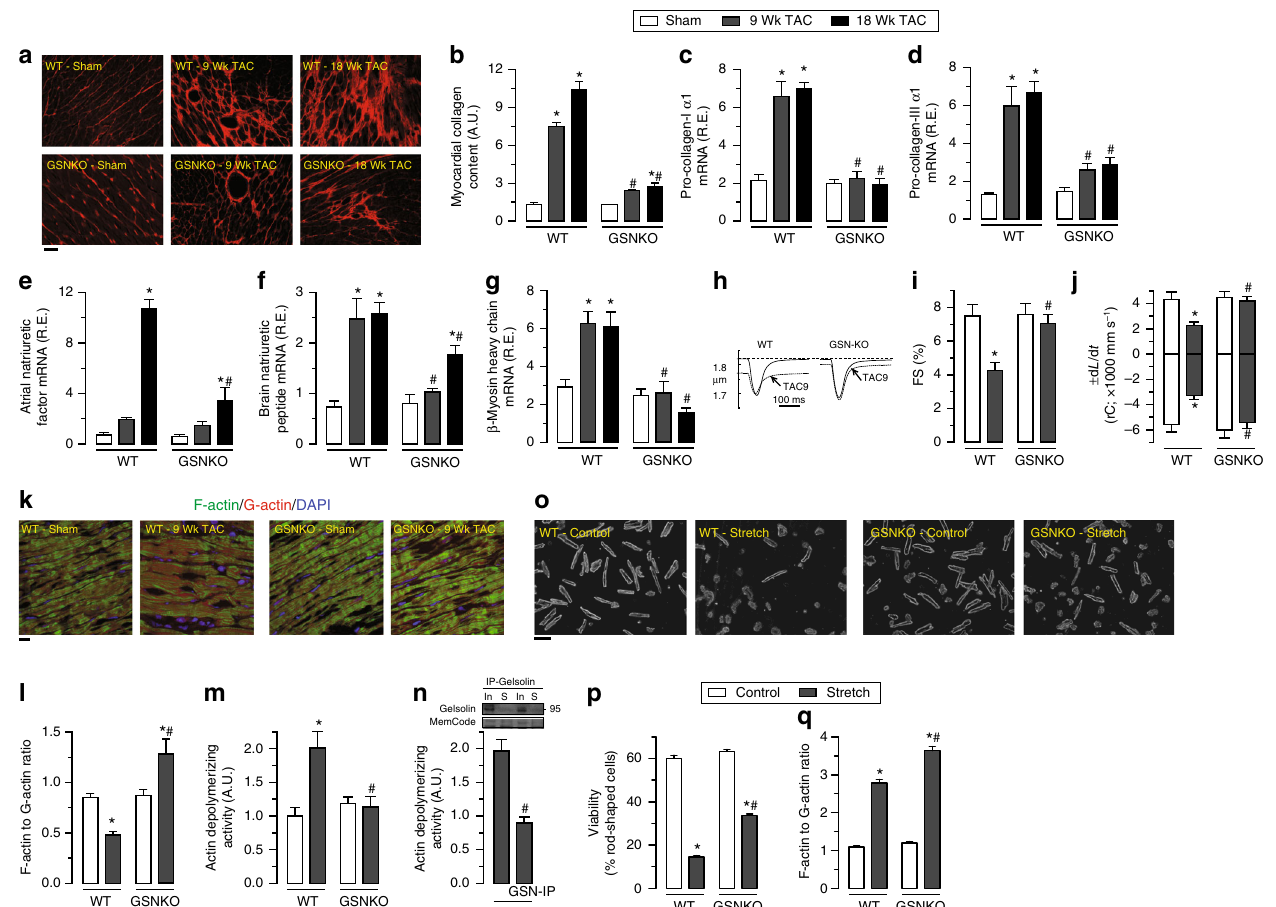
Fig. 2 Loss of gelsolin attenuates pressure overload-induced cardiac remodeling and adverse cytoskeletal remodeling. a , b Histological analyses by PSR ( a ) staining showing increased myocardial fi brosis ( b ) in WT mice which were attenuated in GSNKO mice. c , d Taqman real-time PCR analyses showing increased mRNA expression of pro-collagen-I α 1 ( c ) and pro-collagen-III α 1 ( d ) in WT mice in response to pressure overload-induced biomechanical stress. Loss of gelsolin resulted in attenuation of pressure overload-induced mRNA expression of these extracellular matrix proteins. e – g Taqman real-time PCR analyses showing attenuation of pressure overload-induced increase in mRNA expression of cardiac disease markers including ANF ( e ), BNP ( f ), and β - MHC ( g ) in GSNKO mice compared with the WT mice at 9 and 18 weeks postsurgery. h – j Single cardiomyocyte contractility measurements ( h ) showing attenuation of decreased myo fi lament FS ( i ) and ±d L /d t ( j ) in cardiomyocytes isolated from GSNKO LVs compared with WT LVs in response to pressure overload for 9 weeks. k – m Representative images of F- and G-actin staining ( k ), F- to G-actin ratio ( l ), and actin-depolymerizing activity ( m ) showing increased actin depolymerization in WT hearts in response to pressure overload, whereas loss of gelsolin resulted in attenuation of actin-depolymerizing activity leading to increased F- to G-actin ratio. n Immunoprecipitation of gelsolin from WT — 9 weeks TAC heart tissue homogenate resulting in marked attenuation of actin-depolymerizing activity. o – q Representative phase-contrast images ( o ) and quanti fi cation of viable cardiomyocytes ( p ) showing increased viability in GSNKO cardiomyocytes in response to 24-h cyclical stretch. Loss of gelsolin also resulted in greater increase F to G-actin ratio in response to 24-h cyclical stretch ( q ). In input, S supernatant from immunoprecipitate experiment. Data represent means ± s.e.m. * P < 0.05 compared with the respective sham group, # P < 0.05 compared with corresponding WT — 9 Wk or 18 Wk TAC group as determined by unpaired two-tailed Student ’ s t test ( n ) and one-way ANOVA analysis ( b – g , i , j , l , m , p , q ). Biological replicates: n = 4 ( a , b ), n = 10 ( c – g ), n = 6 ( h – j ), n = 4 ( k – m ), and n = 3 ( o – q ). For in vitro experiments, each biological replicate was mean of technical replicates ( o – q ); only biological replicates are plotted and used for statistics. Scale bars show 25 µ m ( a , k ) and 100 µ m ( o